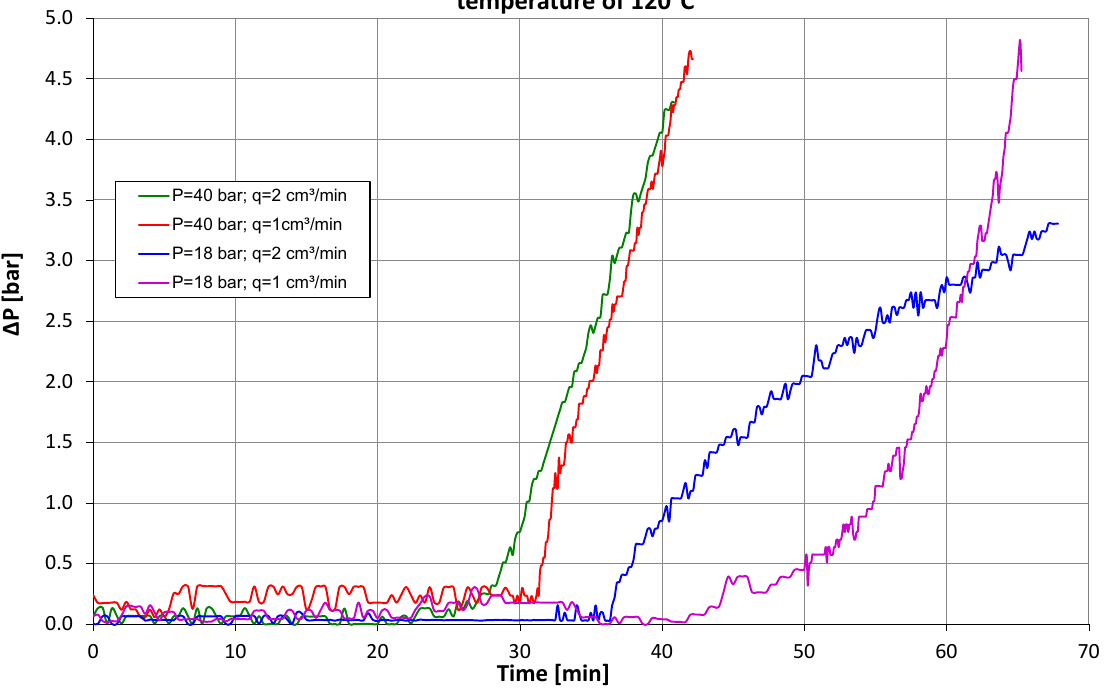
Figure 7. Tests for the precipitation of sediments for water “A” modified with sodium bicarbonate (1 g/800 mL) and water “B” at a temperature of 120 °C (measurement error is ±4%).